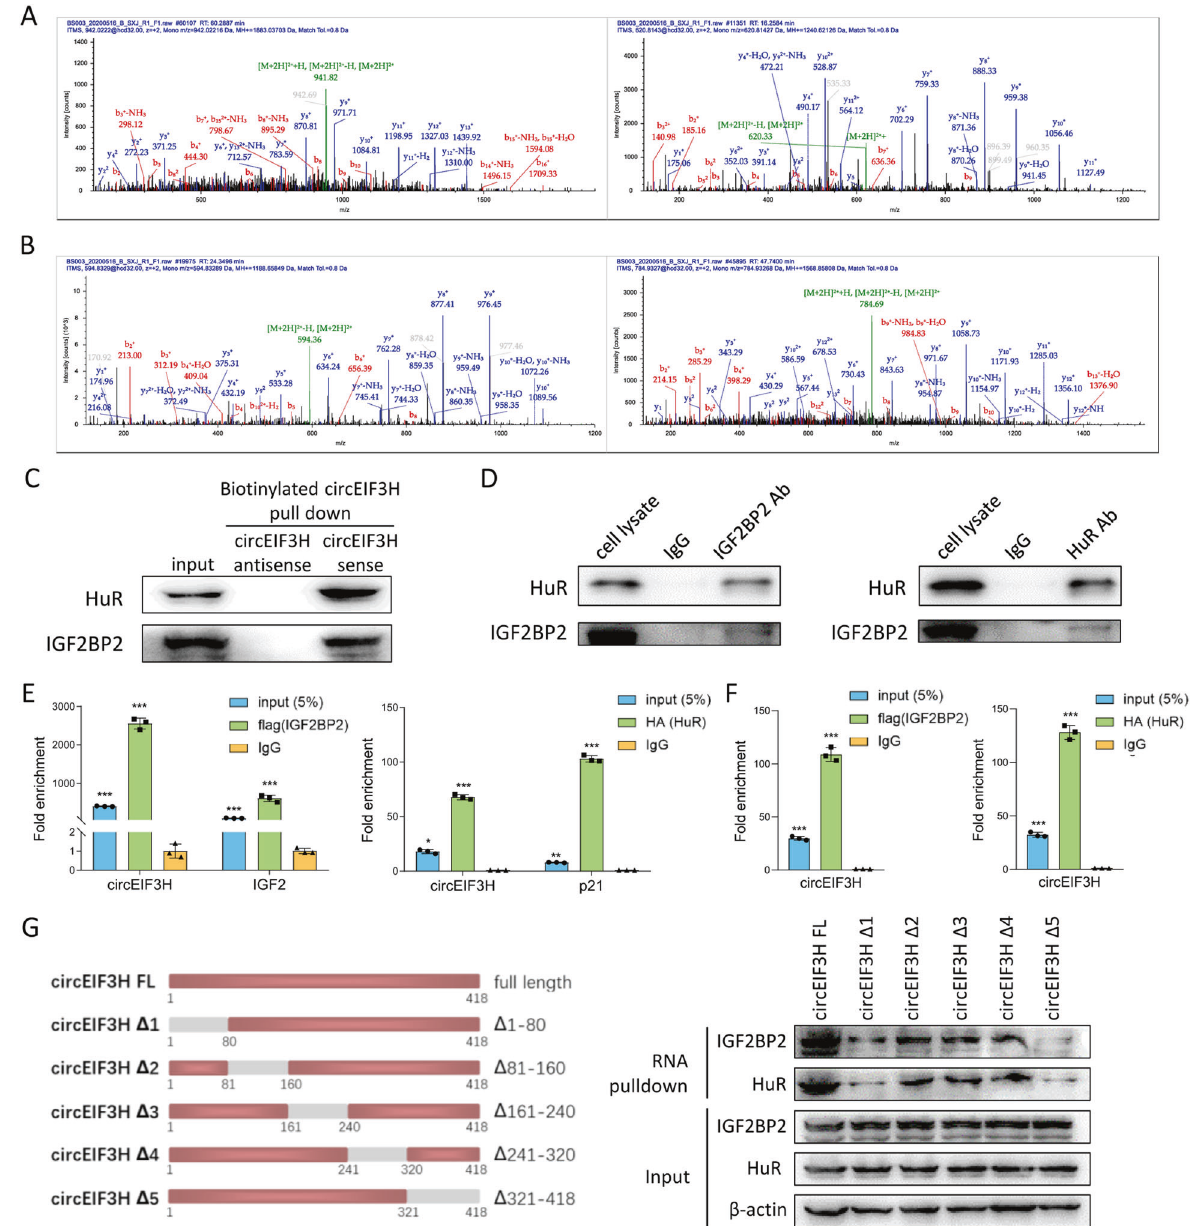
Fig. 3 CircEIF3H interacts with IGF2BP2 and HuR as a scaffold. A IGF2BP2 protein-speci fi c peptides TVNELQNLTSAEVIVPR and IAPAEGPDVSER were identi fi ed by mass spectrometry. B HuR protein-speci fi c peptides VLVDQTTGLSR and NVALLSQLYHSPAR were identi fi ed by mass spectrometry. C Western blot of the proteins from circEIF3H and antisense circEIF3H pull-down assay. D Co-IP followed by western blot con fi rmed the interaction between IGF2BP2 and HuR. E RIP assays in 293 T cells showed the association of circEIF3H with Flag-tagged IGF2BP2 and HA-tagged HuR. IgG served as a negative control. F RIP assays in MDA-MB-231 cells show the association of circEIF3H with Flag- tagged IGF2BP2 and HA-tagged HuR. G Western blot of IGF2BP2 and HuR in samples pulled down by full-length (FL) or truncated